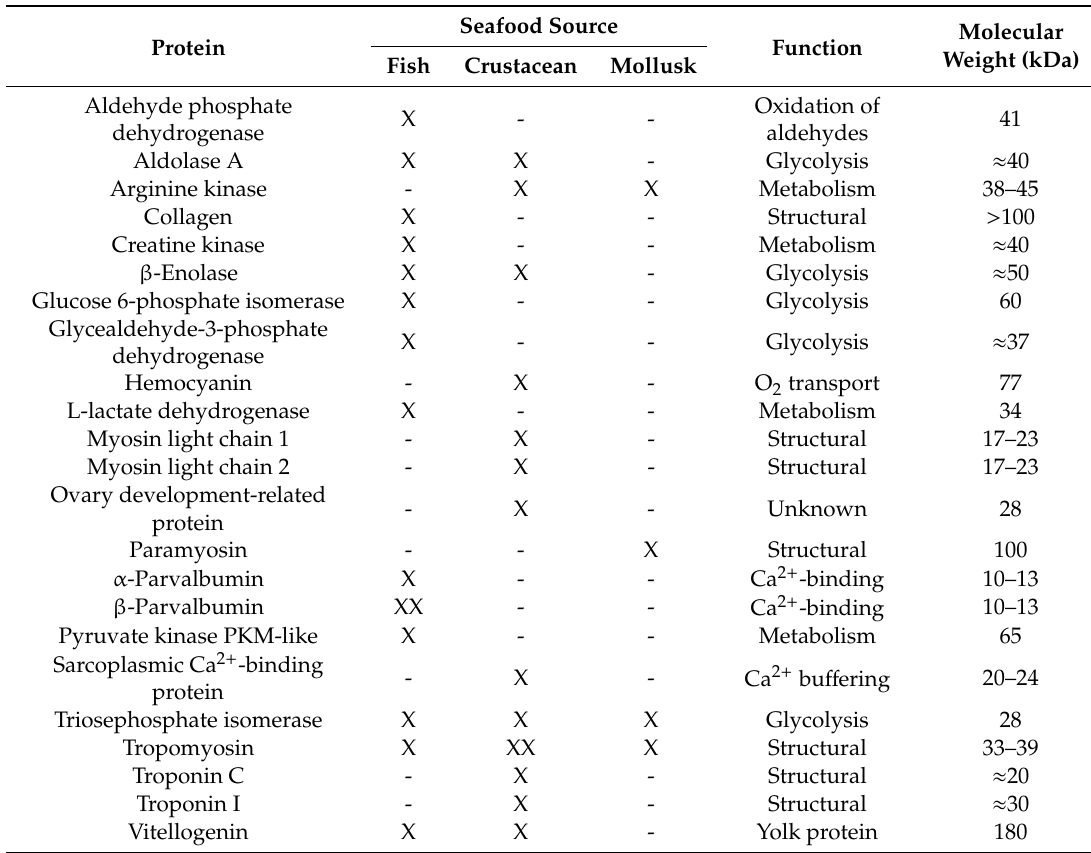
Table 1. Seafood proteins with known IgE reactivity. Data in the table has been retrieved from the World Health Organization (WHO) / International Union of Immunological Societies (IUIS) Allergen Nomenclature Sub-Committee [47]. Proteins are listed in alphabetical order. X indicates in which seafood groups the protein is described as an allergen, XX indicates a major allergen, and - indicates not yet